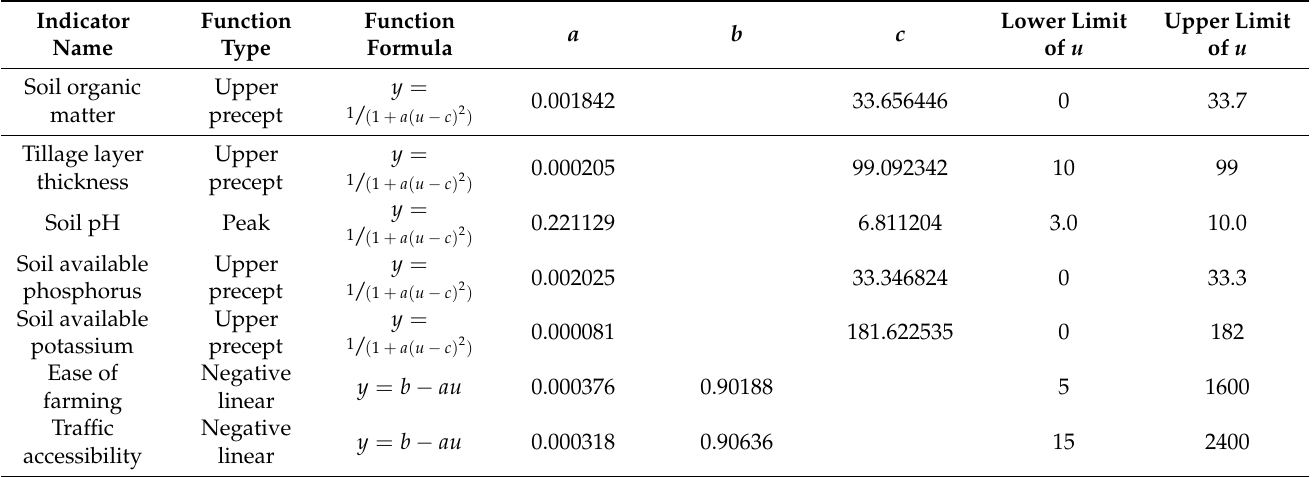
Table 3. Affiliation function of the qualitative